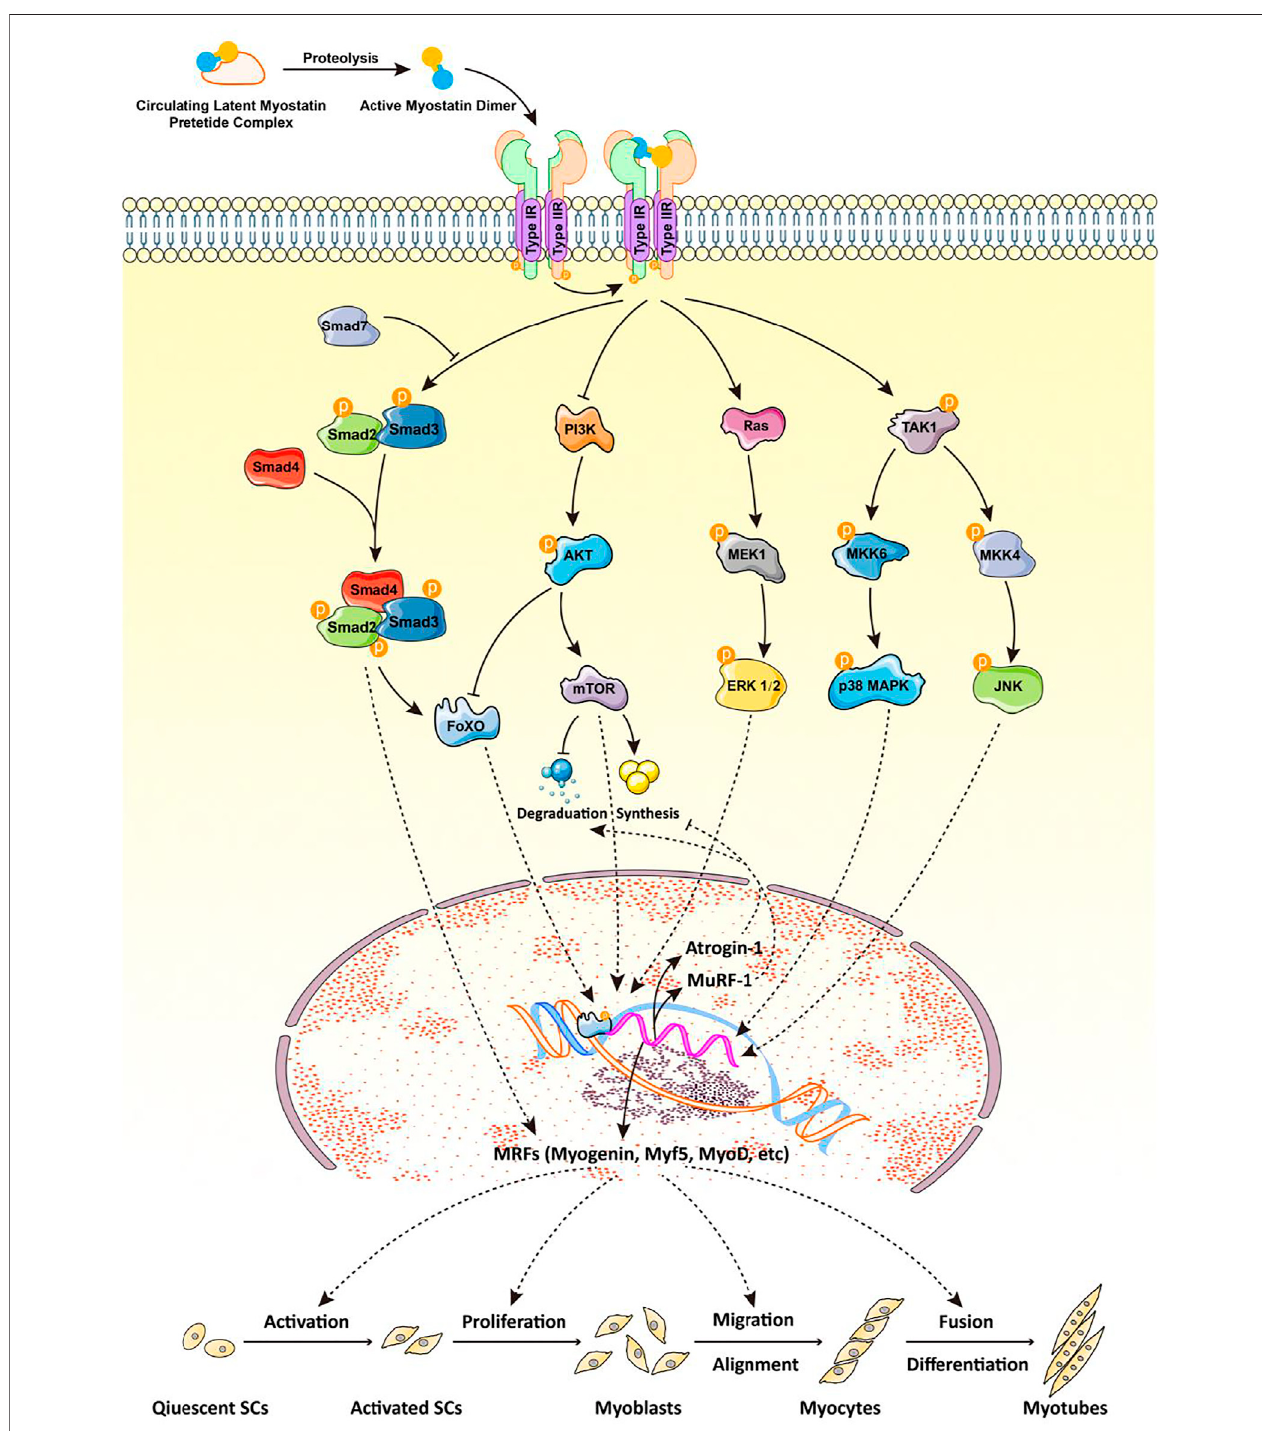
FIGURE 1 | Myostatin and its signaling pathway are involved in myogenesis. The myostatin dimer fi rst binds to ActRIIB, then to ALK4/5 to form a complex; Smad2/3/4 enters the nucleus to regulate the expression of target genes. Different transcription factors bind to the Smad2/3/4 complex, resulting in various functions of the Smad signaling pathway. Smad7 can prevent the phosphorylation of R-Smad by ActRI, thus blocking the myostatin signaling pathway mediated by Smad.Thenonclassicalpathway ofmyostatinsignalinginvolvesthePI3K/Akt/mTORandMAPK signalingpathways,thelatterofwhich mainly includes ERKs, JNKs, and p38MAPK. All of these pathways mediate the transcription of myogenic regulatory factors (myogenin, Myf5, MyoD), MuRF-1, and atrogin-1 to regulate myogenic differentiation and skeletal muscle quality. ActRIIB: activin receptor kinases II-B; ALK4/5: activin receptor-like kinase 4/5; R-Smad: receptor-regulated Smad; PI3K: phosphoinositide 3-kinase; Akt: protein kinase B; mTOR: mammalian target of rapamycin; MAPK: mitogen-activated protein kinase; ERK: extracellular signal-regulated kinase; JNK: c-Jun N-terminal kinase; Myf5: myogenic factor 5; MyoD: myoblast determination protein 1; MuRF-1: muscle RING- fi nger protein-1.